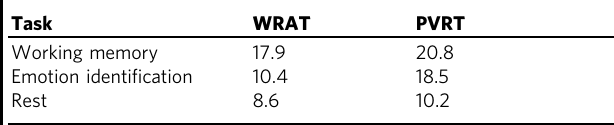
Table 1 Task-based models outperform rest-based models in prediction of two additional intelligence-related